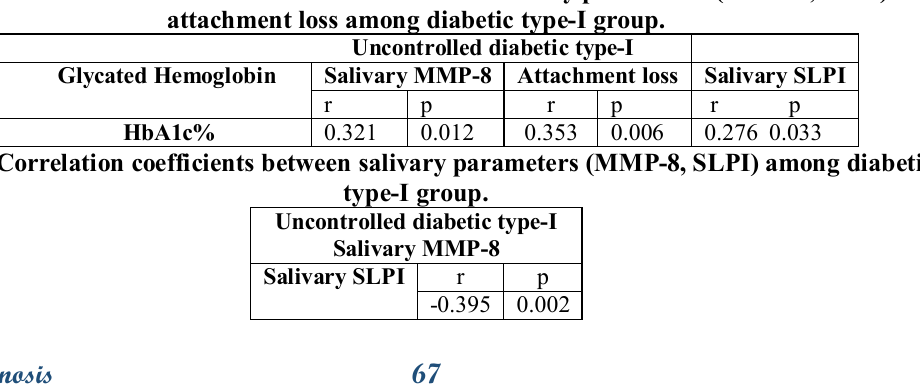
Table 4: Correlation coefficients between HbA1c and salivary parameters (MMP-8, SLPI) and